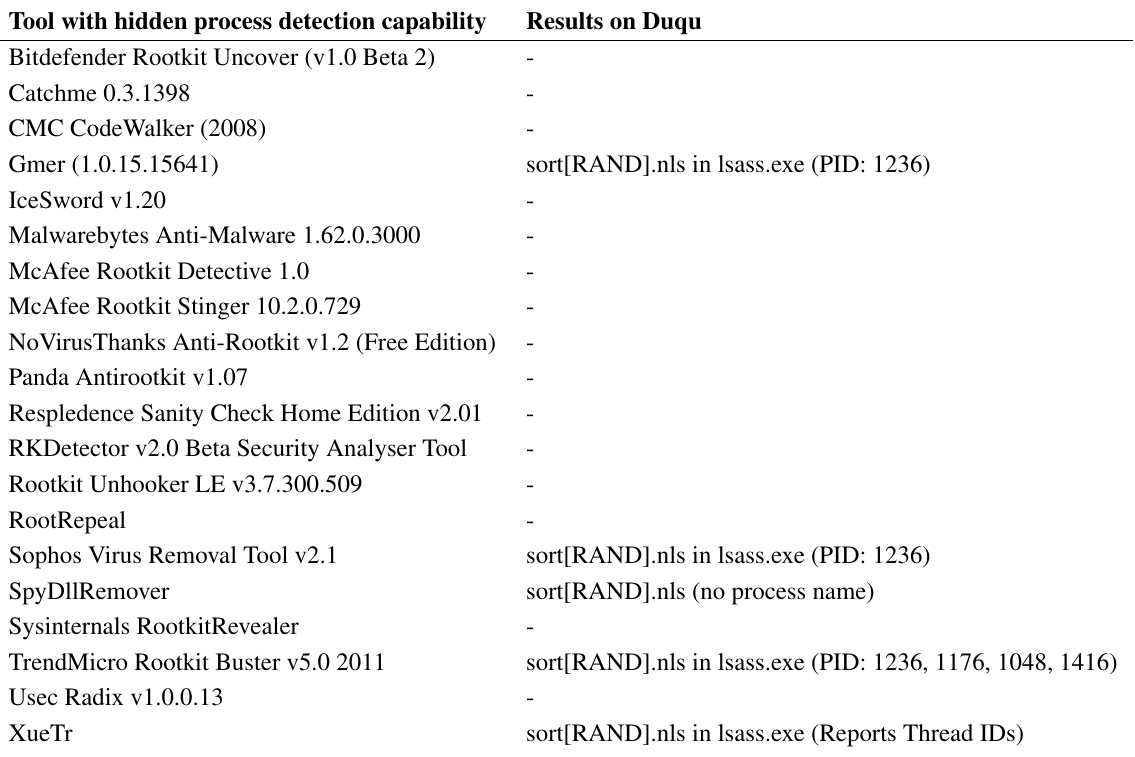
Table 8. Detecting hidden processes/threads/modules with anti-rootkit